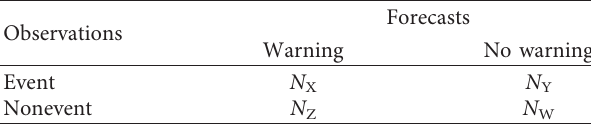
Table 2: Two-by-two contingency table for the assessment of a warning